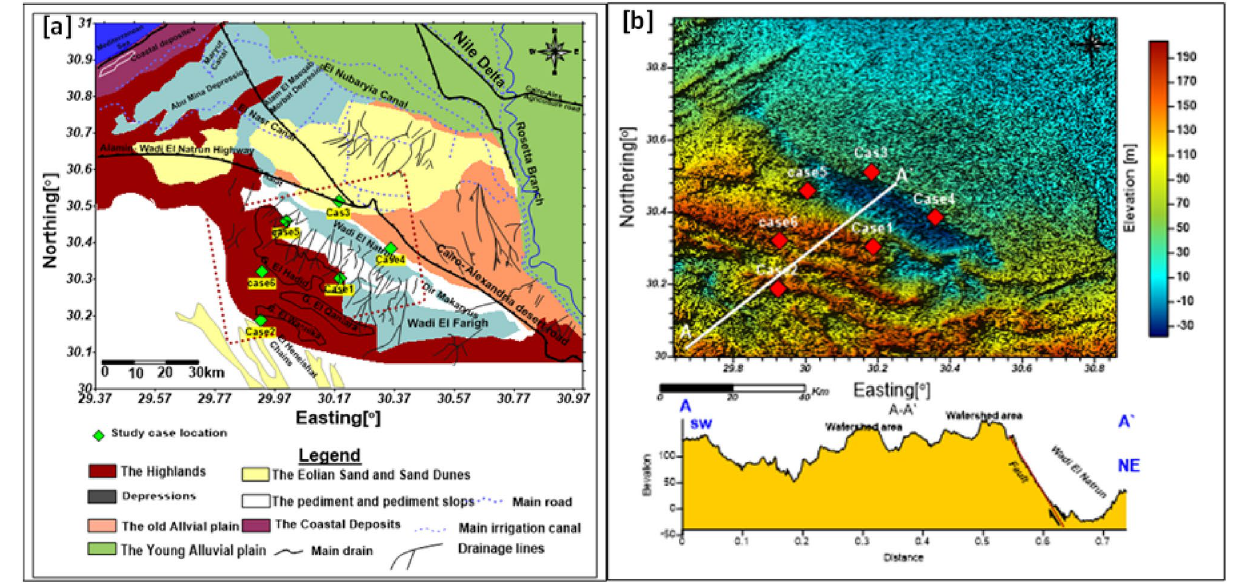
Figure 2. ( a ) Geomorphologic map of West Nile Delta and Wadi El Natrun. Green symbols show case studies locations. ( b ) Digital Elevation Image map with profile A–A ′ crossing the study cases showing main geomorphic unit. Red symbols show locations of case